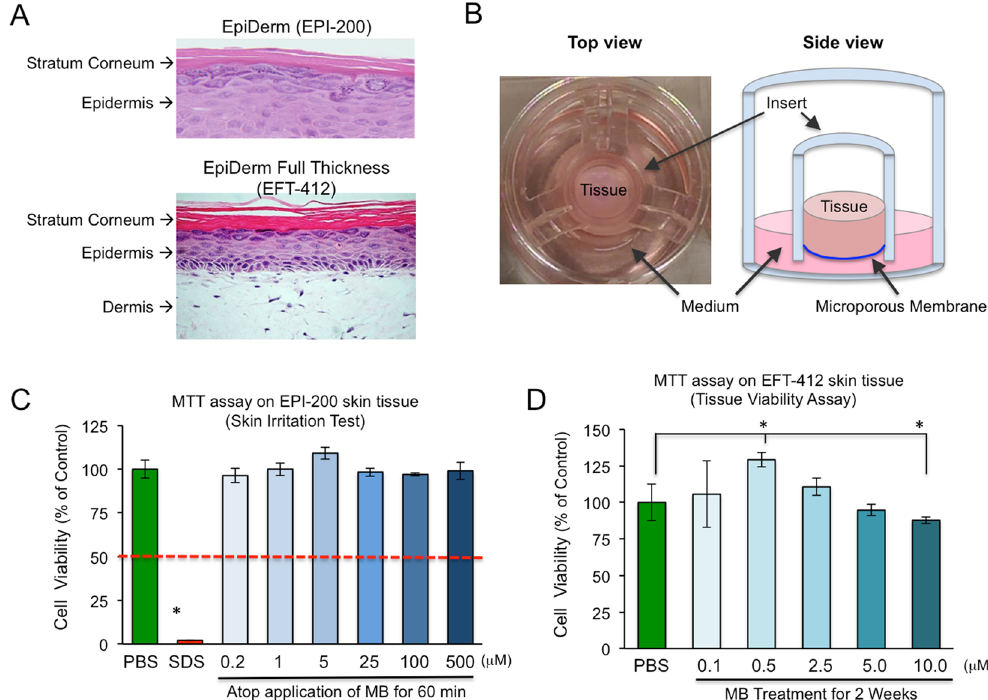
Figure 4. MB increases tissue viability and shows no signs of irritation on the in vitro reconstructed 3D human skin. ( A ) H&E staining images showing two kinds of engineered human skin tissues (obtained from MatTek, Ashland, USA). Upper Panel: EpiDerm EPI-200 consists of normal human-derived epidermal keratinocytes (NHEK) and the outer-most stratum corneum layer. This model was only used for the in vitro skin irritation test in 3 C. Lower Panel: EpiDerm Full Thickness EFT-412 consists of normal human dermal fibroblasts (NHFB), NHEK and stratum corneum, which was used for most of the 3D skin tissue experiment described in this study. ( B ) Schematic illustrations of top (Left Panel) and side (Right Panel) views of the engineered 3D skin tissue cultured on a microporous membrane insert. ( C ) The short term skin irritation test. MTT assay was conducted on EPI-200 tissues after topical applications of MB in serial doses for 60 minutes. 5% SDS was used as a positive control (strong irritation) and PBS was used as a negative control (no irritation) in this experiment. ( D ) Long term cell viability test. MTT assay was conducted on EpiDerm Full-Thickness (EFT-412) skin tissues that had been treated with MB for two weeks at the indicated concentrations ( * p <